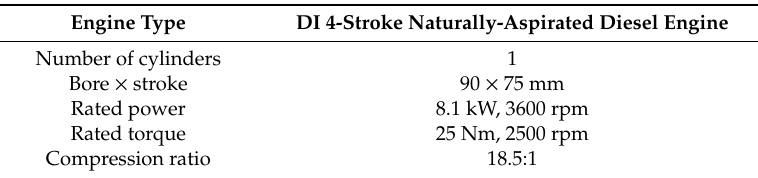
Table 3. Ruggerini RF91 engine specifications.